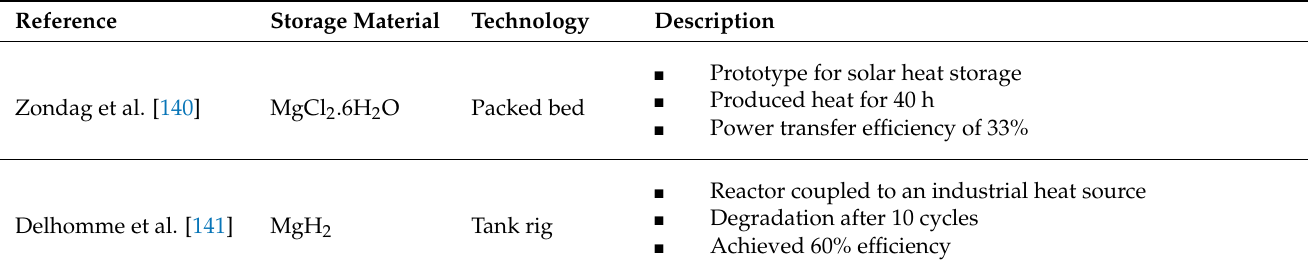
Table 7. Examples of TCES system prototypes and